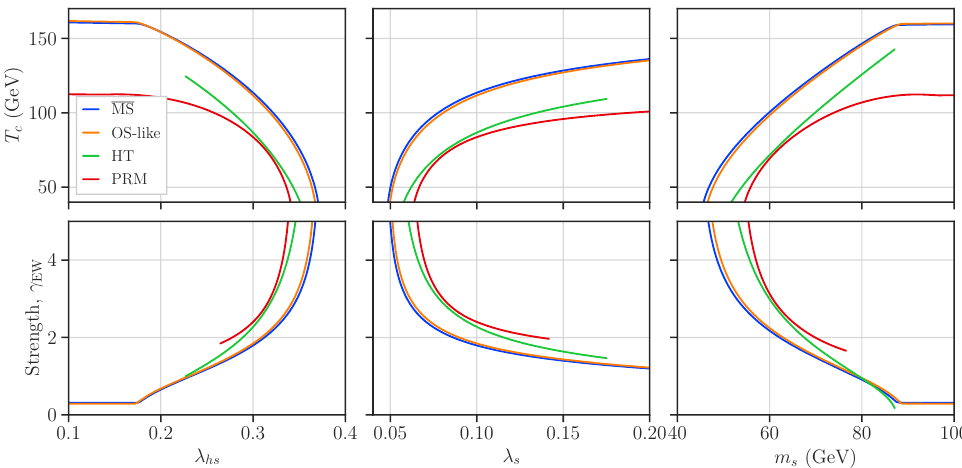
Figure 11 . Critical temperature and transition strength in the MS scheme, OS-like scheme, HT approximation, and PRM method. The other settings ( ξ = 0 , Q = m method and GC_SelfEnergy_Sol ) are the same if they are optional in that scheme. In each of the panels we vary one input parameter about the benchmark point in eq. (4.1).